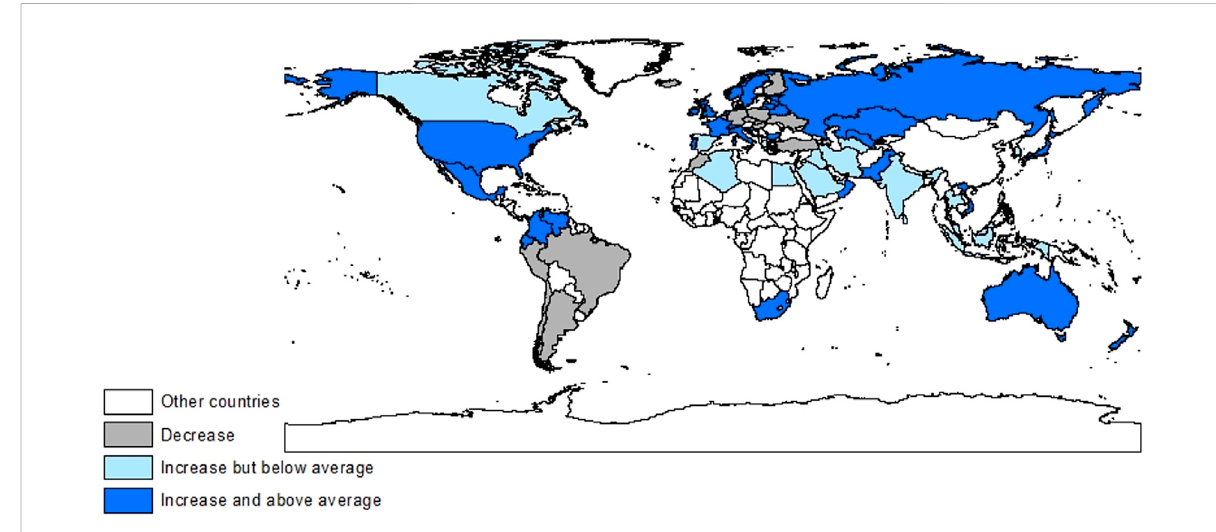
FIGURE 2 TC index change rate before and after the BRI was proposed in